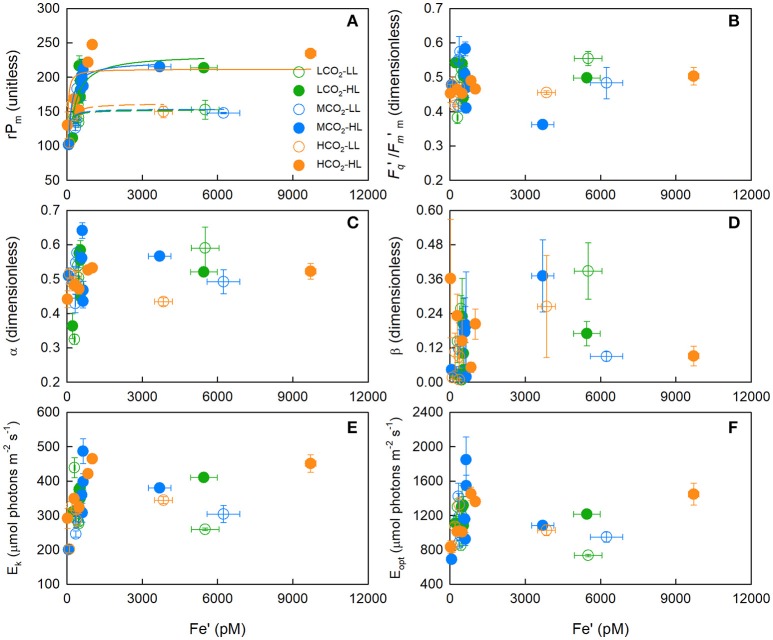
The mean (± SE) maximum relative PSII electron transport rate (rPm) (A), photochemical efficiency of PSII in the dark-acclimated state (Fv/Fm) (B), initial slope of the rP-Fe′ curve (α) (C), slope of photoinhibition (β) (D), light-saturated parameter (Ek) (E), and light intensity at which rP was maximal (Eopt) (F) for T. erythraeum IMS101. Cultures were acclimated to three targeted CO2 concentrations [Low = 180 μatm (green circles), Mid = 380 μatm (blue circles) and High = 720 μatm (orange circles)], two light intensities [LL = 40 μmol photons m−2 s−1 (open circles), HL = 400 μmol photons m−2 s−1 (closed circles)], across a range of Fe′ concentrations (~20–9,600 pM), at optimal temperature (26°C). In (A), the dashed and solid lines are the Michaelis-Menten function curve fits for the low light and high light treatments, respectively; where green, blue and orange lines are for low, mid and high CO2 treatments, respectively. Data in the iron-limited region only (20–1,010 pM Fe′) is presented in Supplementary Figure 2.